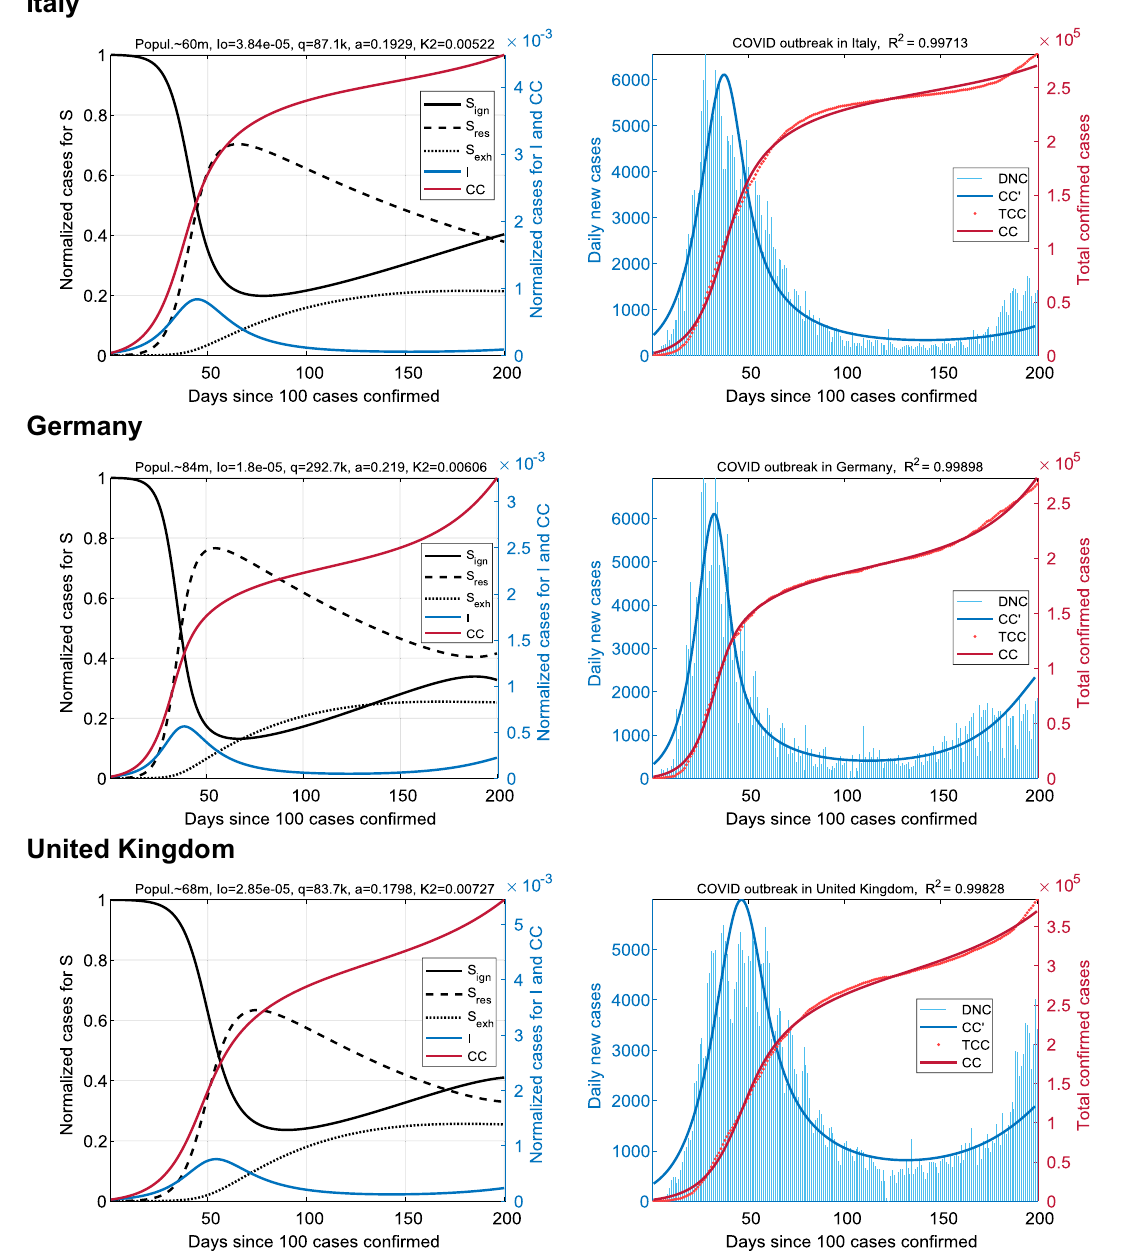
Figure 2. Earliest coronavirus outbreaks in Europe. Results for Italy (top panel), Germany (center), and United Kingdom (bottom). The dynamics of the epidemic spread are qualitatively similar and are characterized by a profile containing the full first wave and the beginning of the second